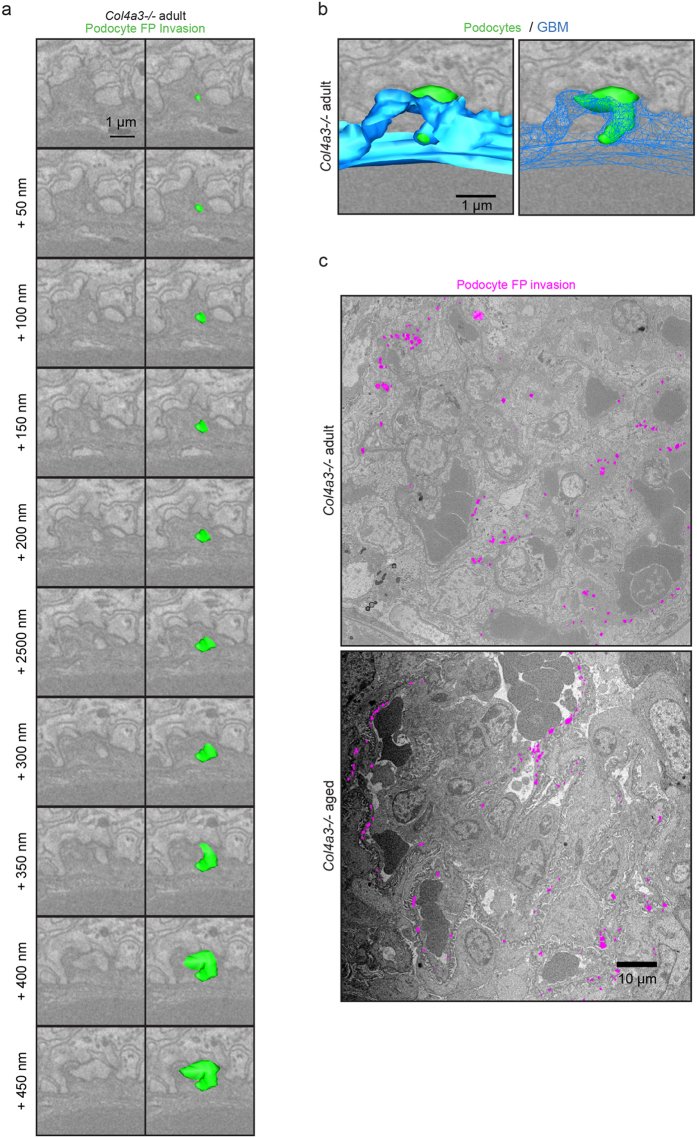
Identification of podocyte FPs invading the GBM in Alport syndrome.(a) Tracking of cellular material embedded within the GBM through 50 nm sections revealed that this material originates from podocyte FPs. (b) Tilted view of the model generated in A. showing the interaction of the invading FP with the BM. (c) Distribution of GBM invasions of podocyte origin (magenta) recorded in 10,000 μm3 glomerular volume. Podocyte FP invasions were not present in wild type adult or Col4a3+/− mice, they were rarely observed in young Col4a3−/mice, but were abundant in adult and aged Col4a3−/− mice. GBM, glomerular basement membrane.